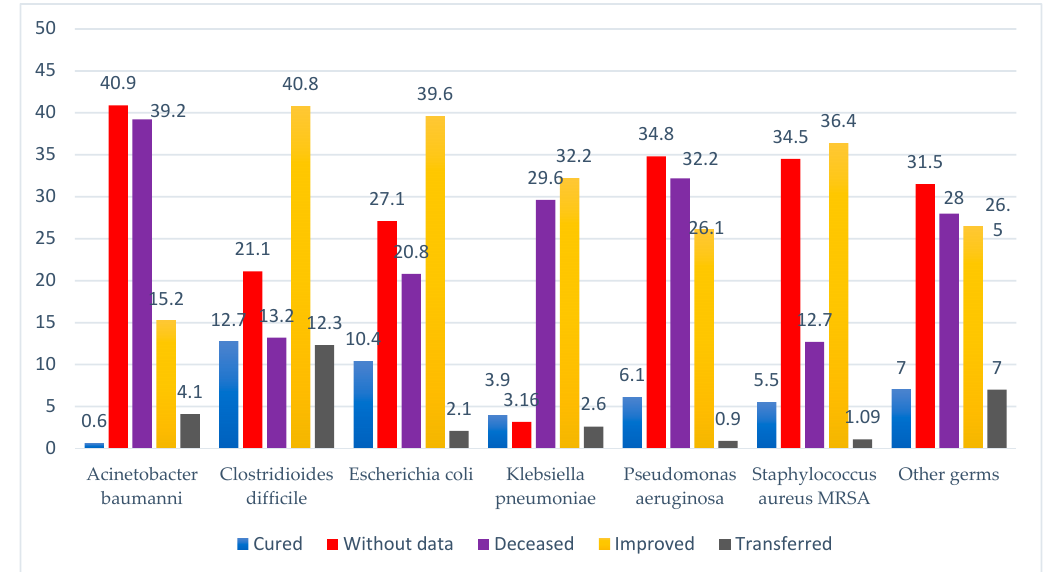
Figure 4. The evidence of the pathogen according the patient’s status upon discharge.